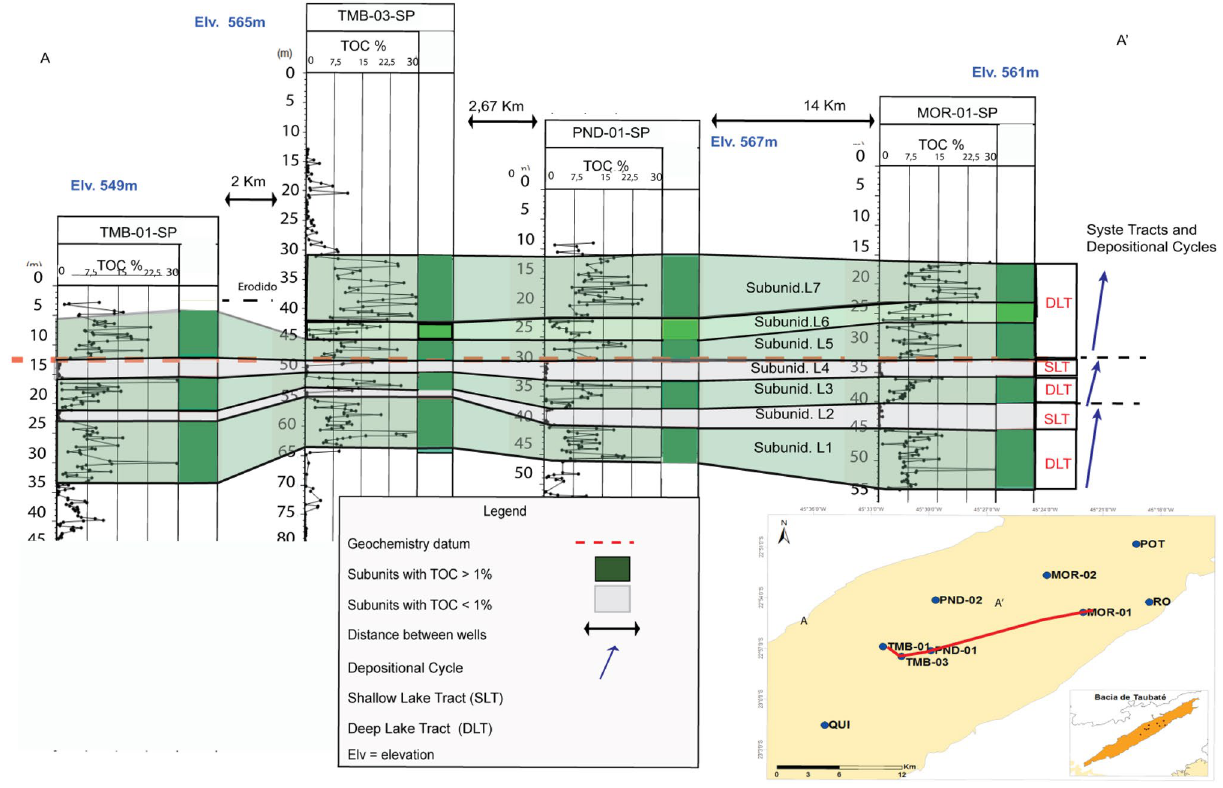
Fig. 4 Correlation A-A’ between wells TMB-01-SP, TMB-03-SP, PND-02-SP and MOR-01-SP, based on TOC